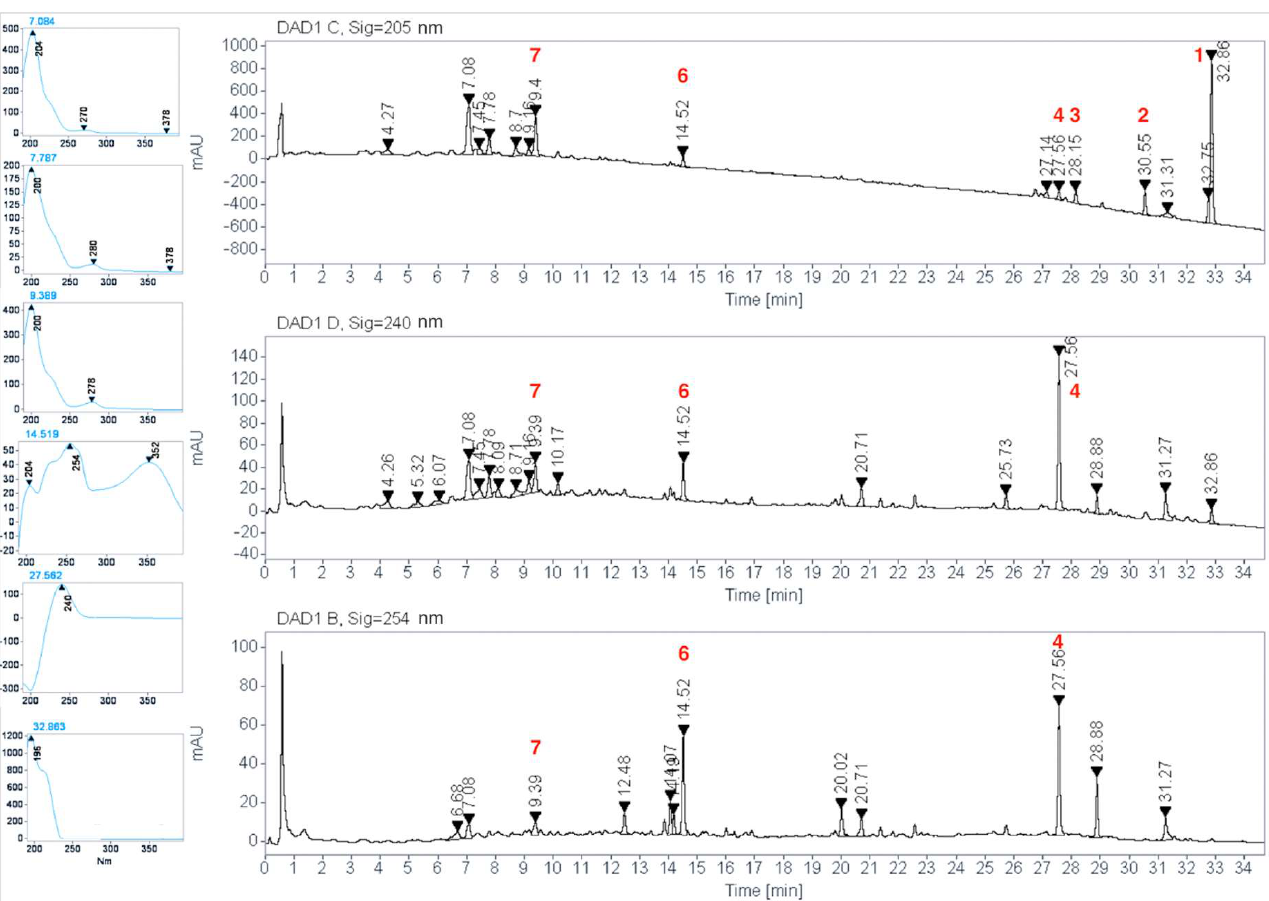
Figure 5. HPLC profile of the EWE of C. guatemalensis at 205, 240, and 254 nm and their UV spectra at some peaks at different retention times.